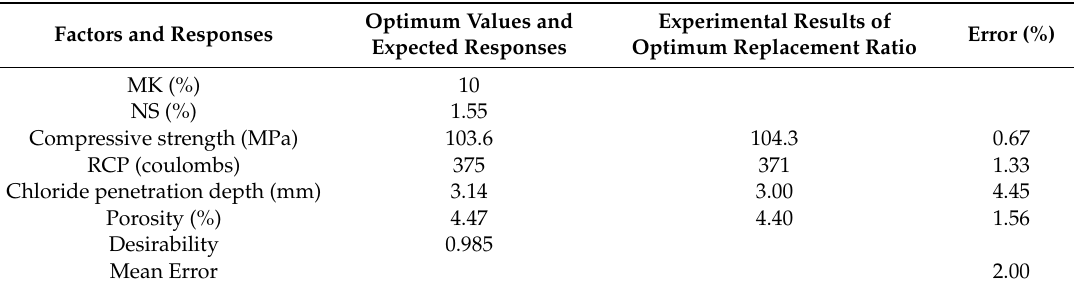
Table 7. The results of theoretical responses and additional experimental responses of optimal mix